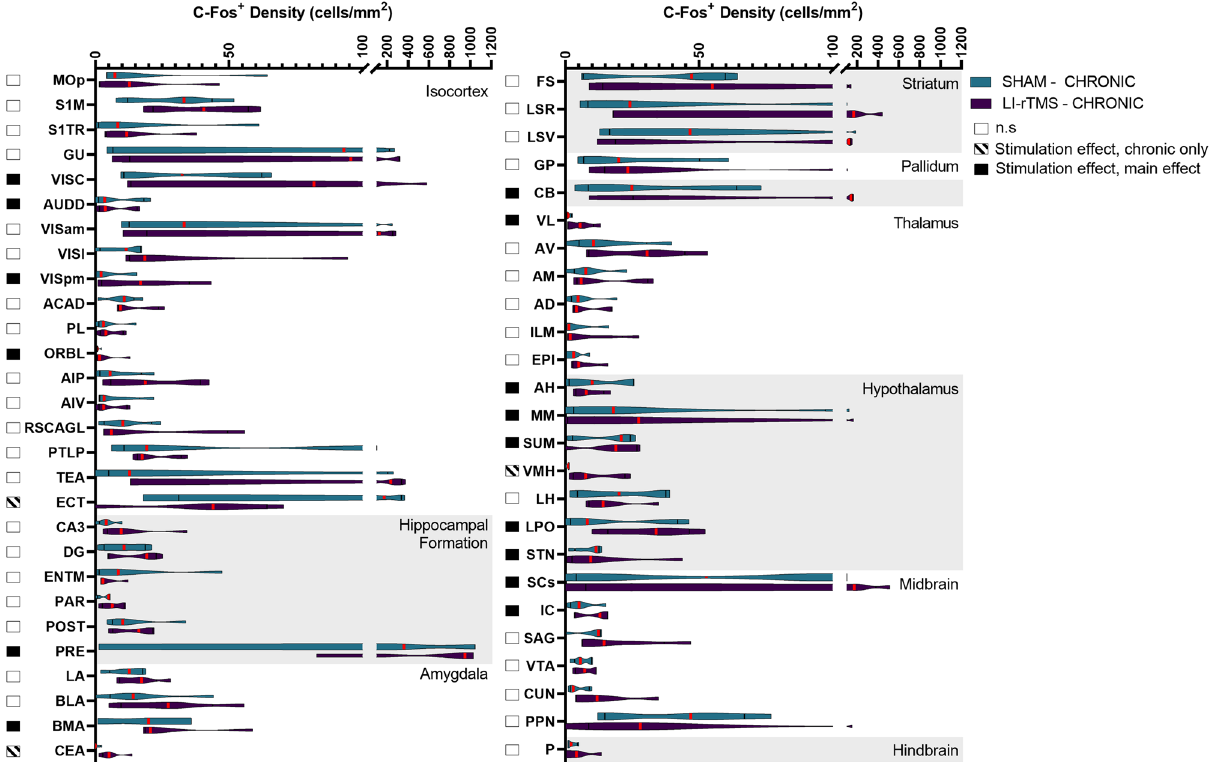
Figure 2. C-Fos cell density in mice in the chronic stimulation group for regions which had a significant effect related to stimulation across all groups. Violin graphs represent c-Fos cell density (cells/mm 2 ) for mice that received acute active or sham stimulation organised by hierarchical brain regions. Red lines indicate the median value. Shaded boxes to the left of the region name indicate whether there was a significant stimulation effect for the region.